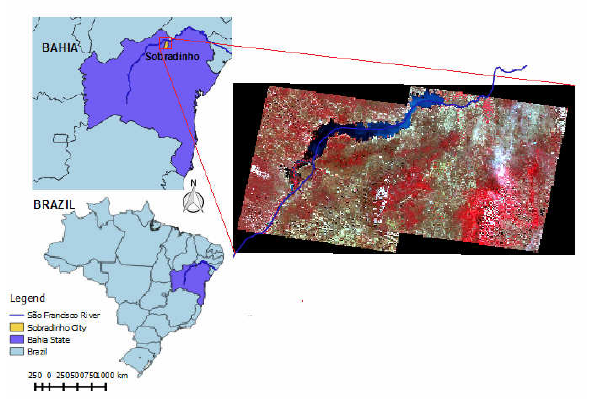
Figure 1: Localization of Sobradinho reservoir and image TM/Landsat-5, false color composition, acquired in 10 and 16 of june of 2011 with the São Francisco River